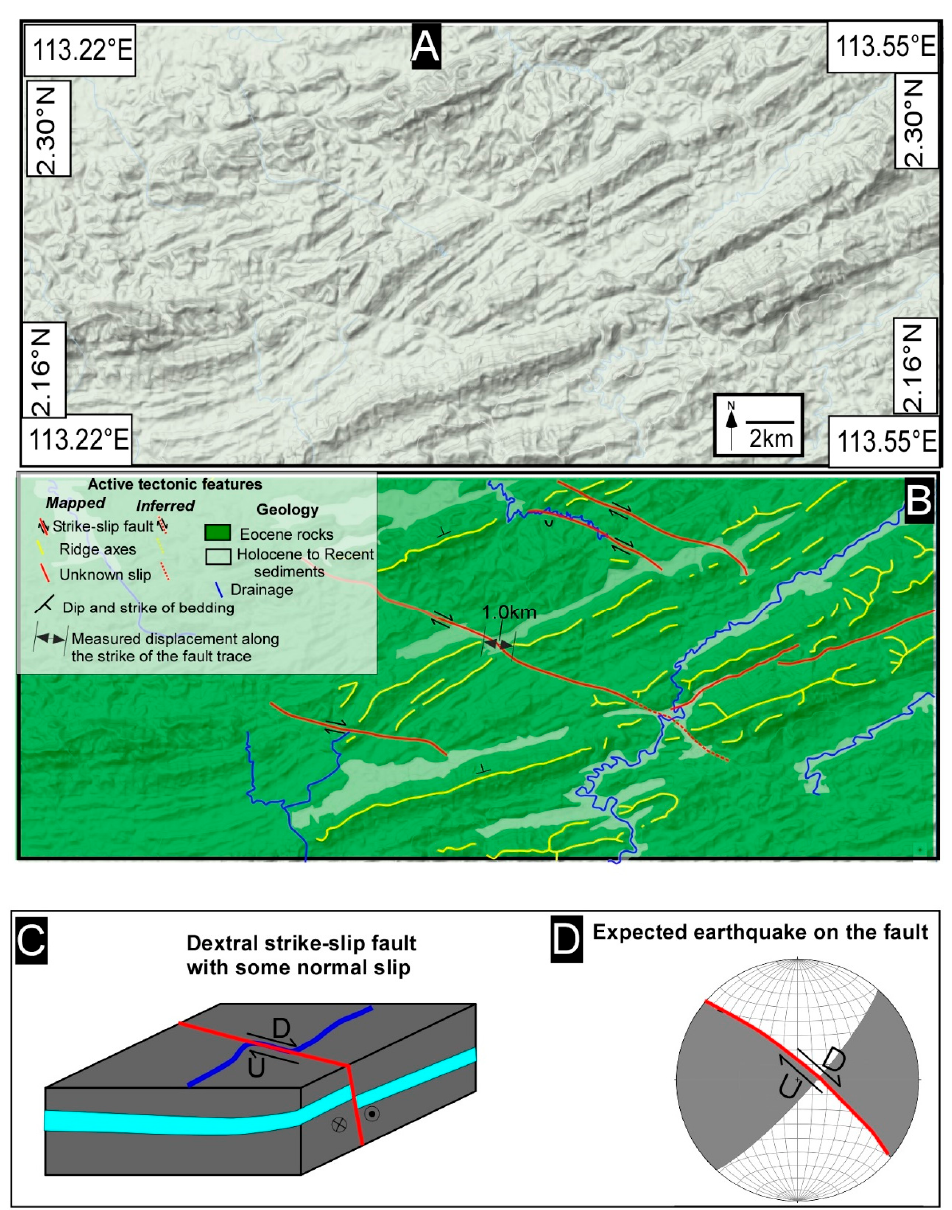
Figure 5. ( A ) Un-interpreted Google terrain satellite image. ( B ) Example of clear dextral strike-slip faulting, and poorly developed nature of sinistral strike-slip faulting in this region. ( C ) Cartoon shows the possible dip and dip direction of faulting. ( D ) The expected fault plane solution.